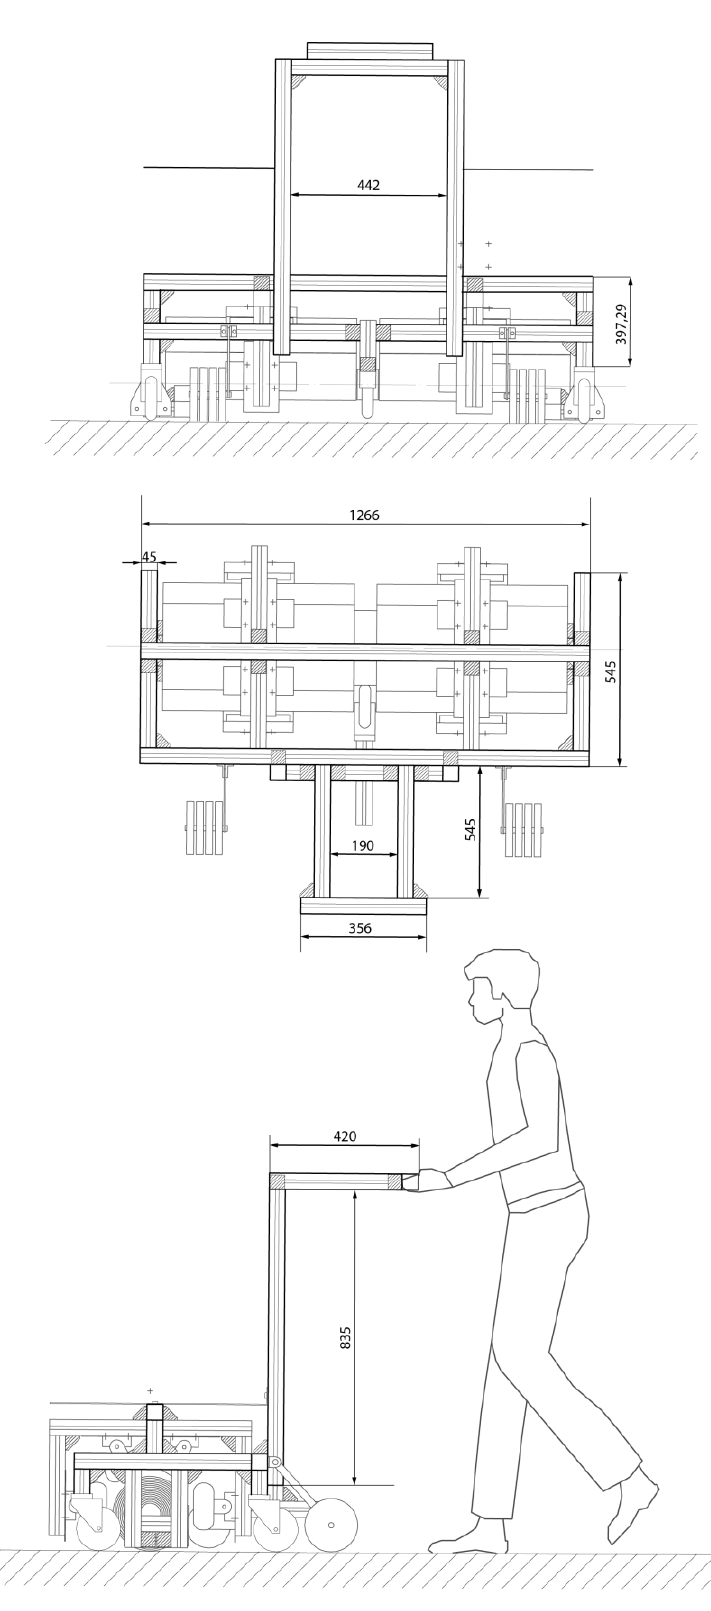
Figure 2. Main dimensions of the equipment. Dimensions are given in millimeters.